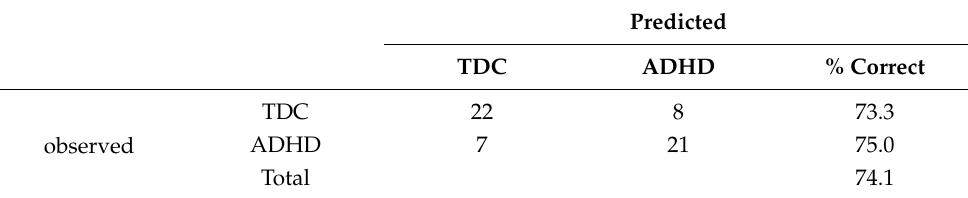
Table 3. Classification of ADHD and TDC based on odor